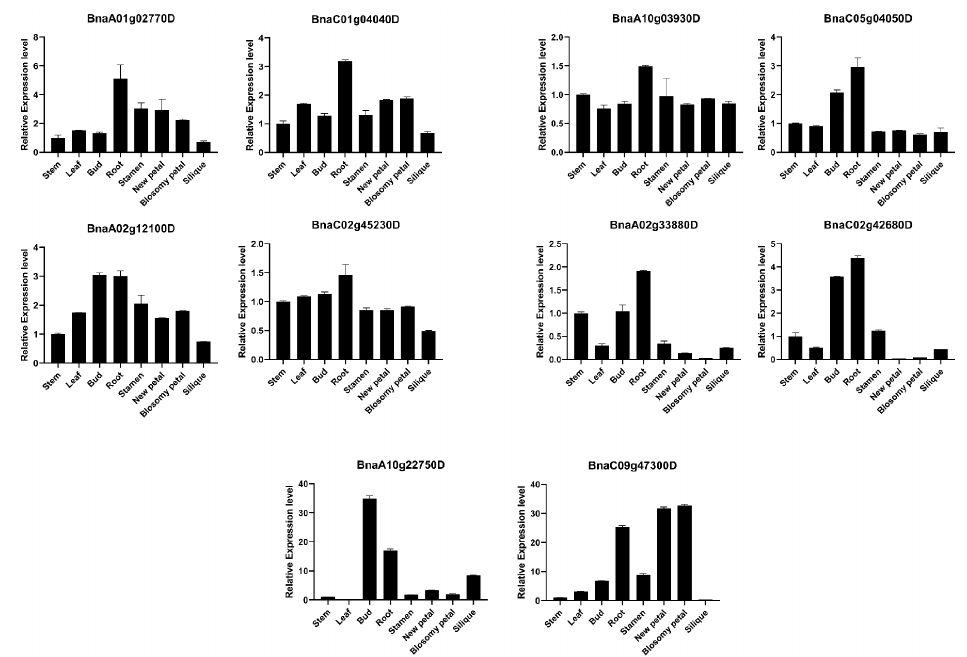
Figure 7. A qRT-PCR expression analysis of 10 ARI genes in eight different tissues of B. napus . The 2 − ∆∆ CT method was used to analyze the results. The error bars indicate the standard error of the mean of three biological replicates for every tissue.